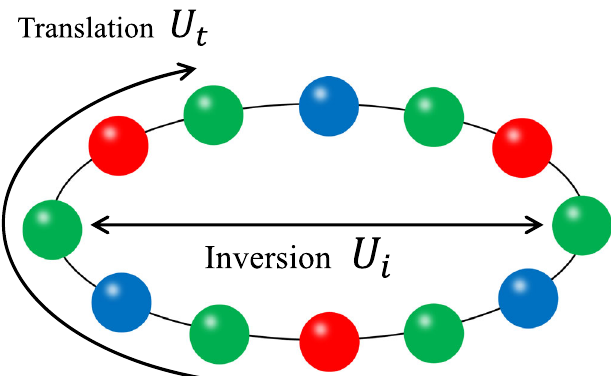
FIG. 6. An example of dihedral group symmetry in a one- dimensional lattice with the periodic boundary condition. The system is invariant under spatial translation and inversion; these two operations generate a dihedral